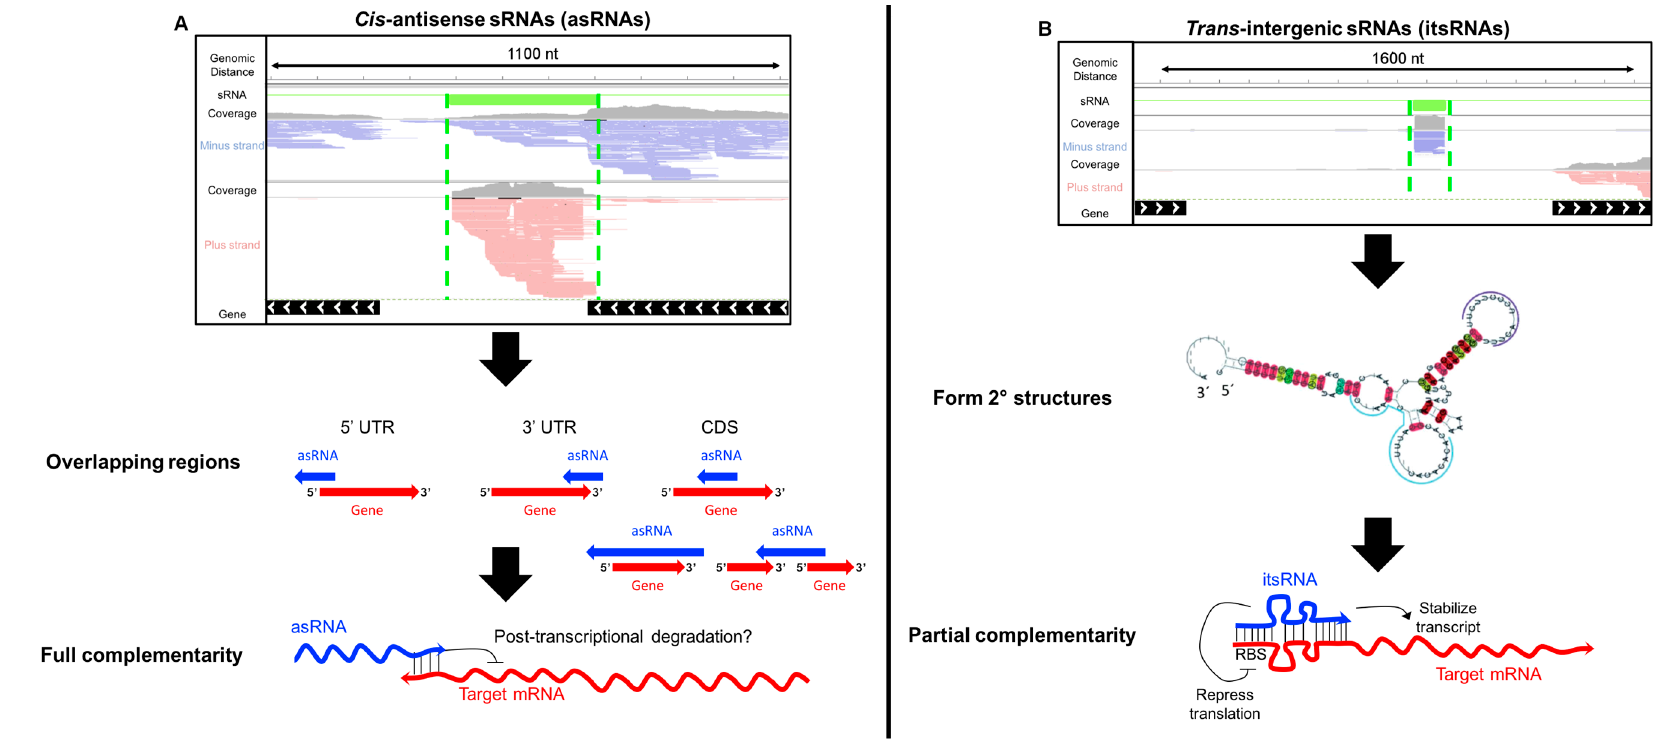
Figure 1. Classes of small non-coding RNAs (sRNAs) discovered in Archaea. Genome viewer of ( A ) antisense sRNAs ( cis -acting) and ( B ) intergenic sRNAs ( trans -acting). Paired-end reads (100 bases) were mapped to the Haloferax. volcanii National Center for Biotechnology Information (NCBI) reference genome. Reference genes are marked as black lines with white arrows indicating their location on the plus strand (>) or minus strand (<). Reads marked in red are transcribed from the minus strand while blue reads are transcribed from the plus strand. Green lines indicated sRNAs. Coverage plots are in gray. Diagrams of classes of antisense RNAs (asRNAs) are shown based on binding attributes: overlapping the 3’ untranslated region (UTR), the 5 ′ UTR, within the coding sequence (CDS), extending past the CDS and overlapping multiple mRNAs. An example of an intergenic sRNA secondary structure is shown in ( B ) [5]. Reported regulatory roles of archaeal sRNAs are shown at the bottom.